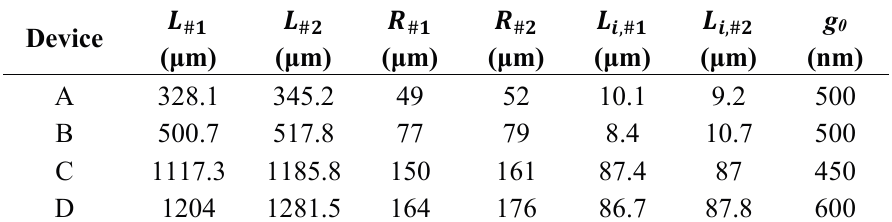
Table 2. Dimensions of fabricated SOI Vernier